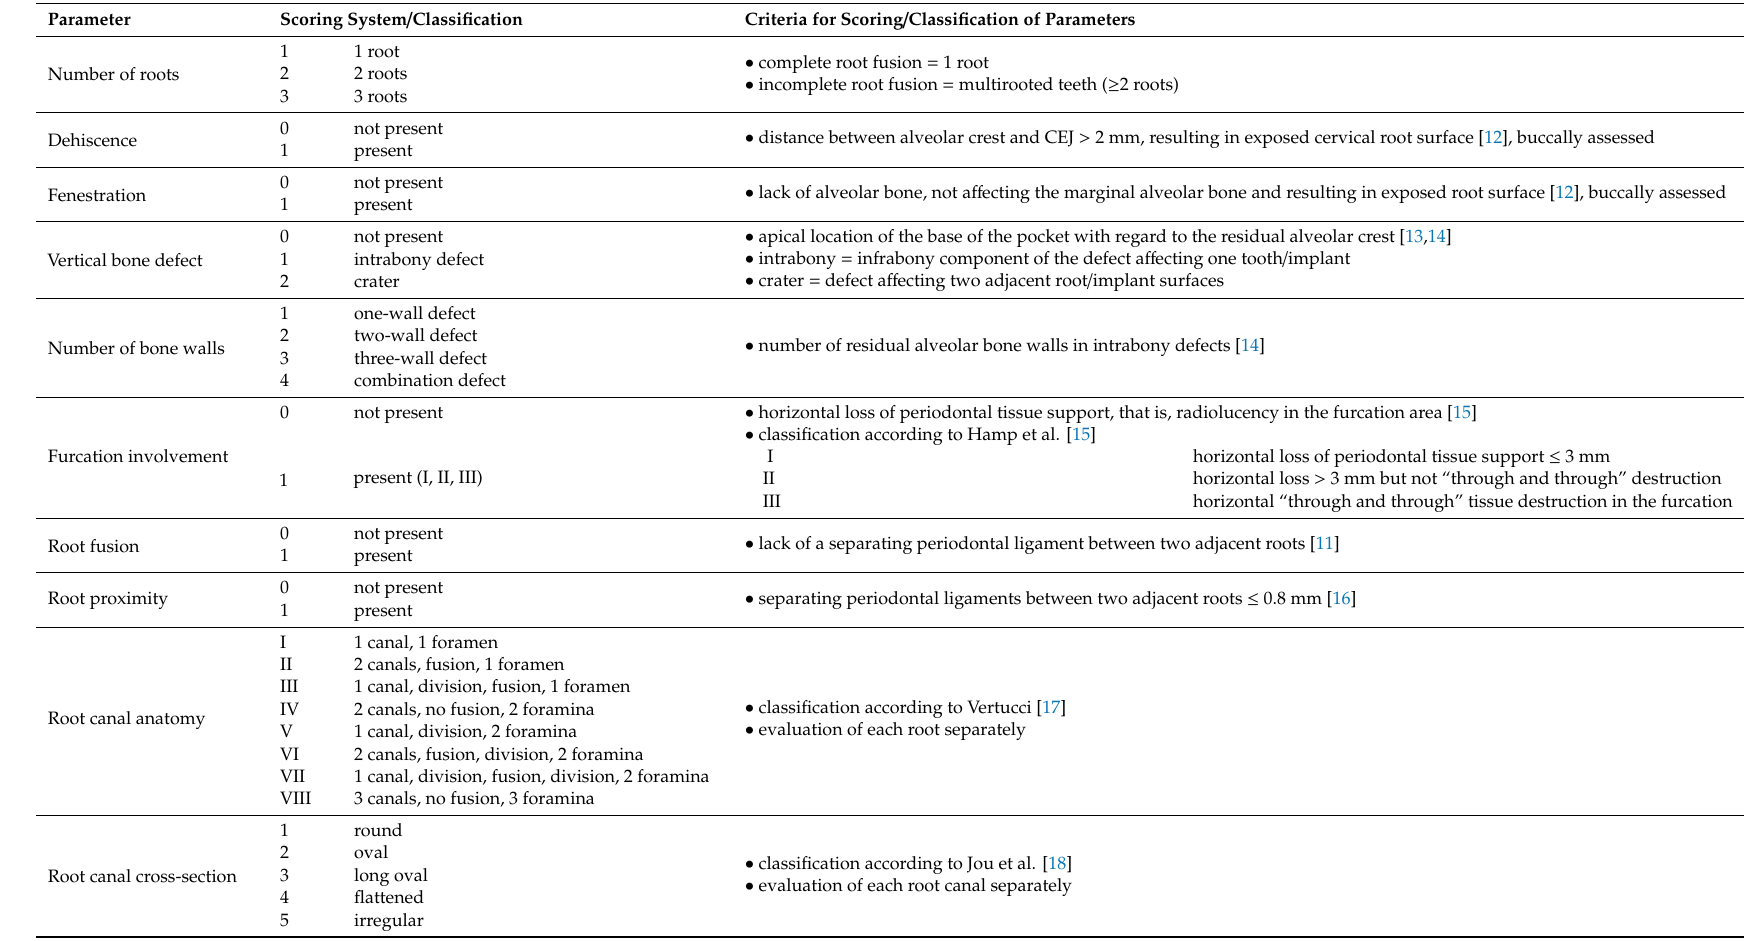
Table 1. Dental and periodontal parameters, related scoring system / classification and